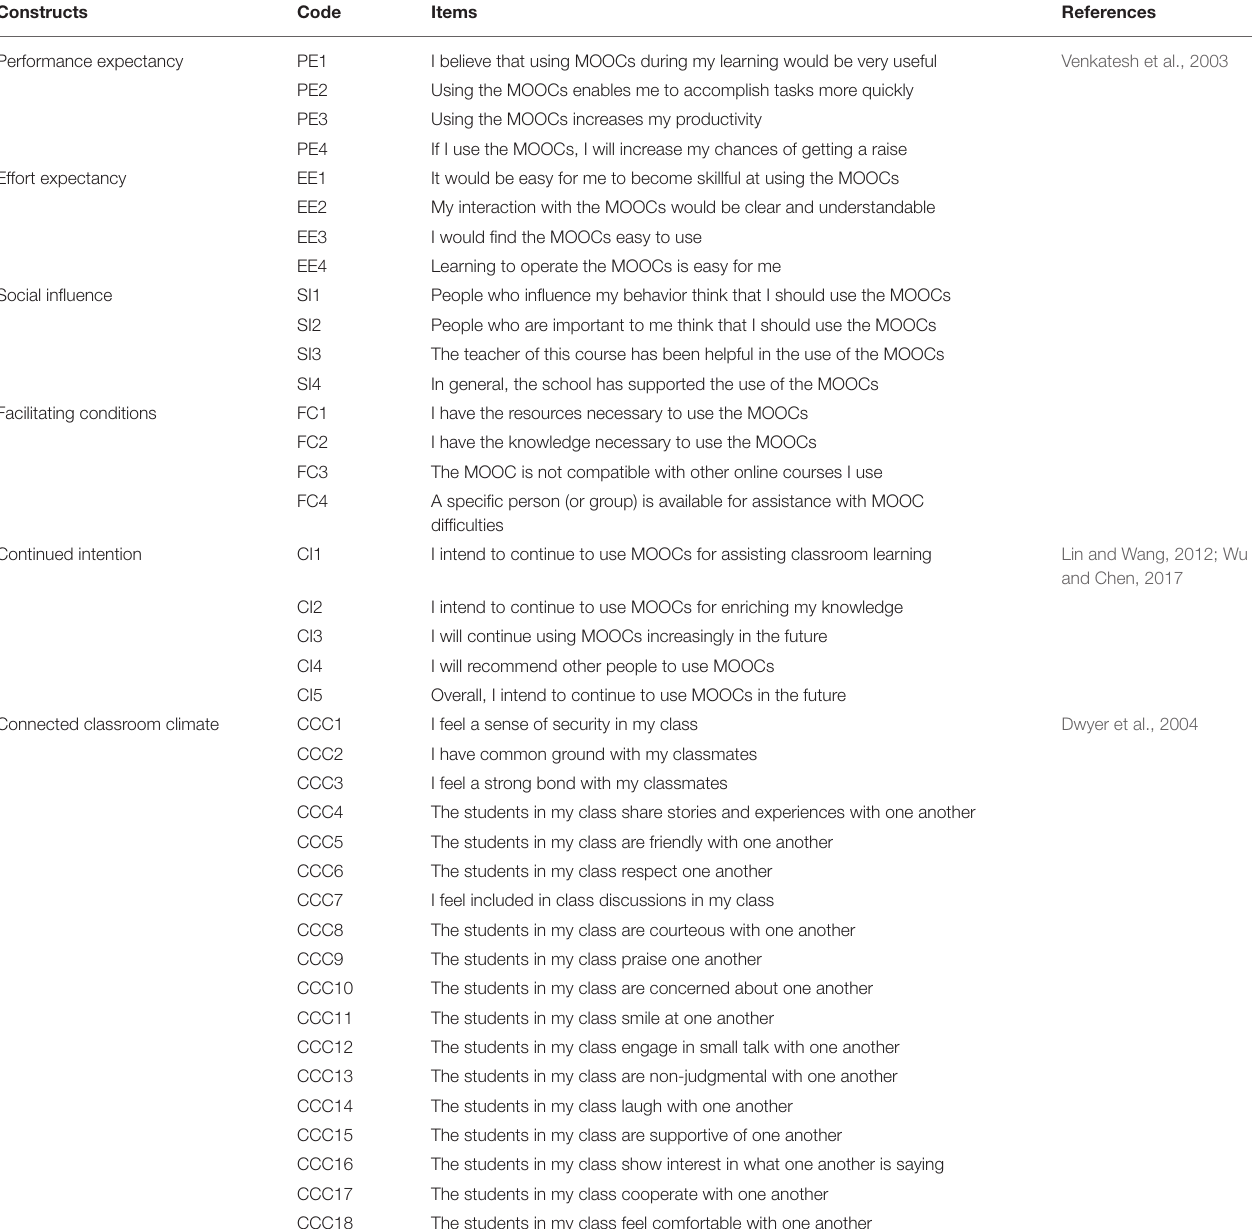
TABLE 2 | Measurement